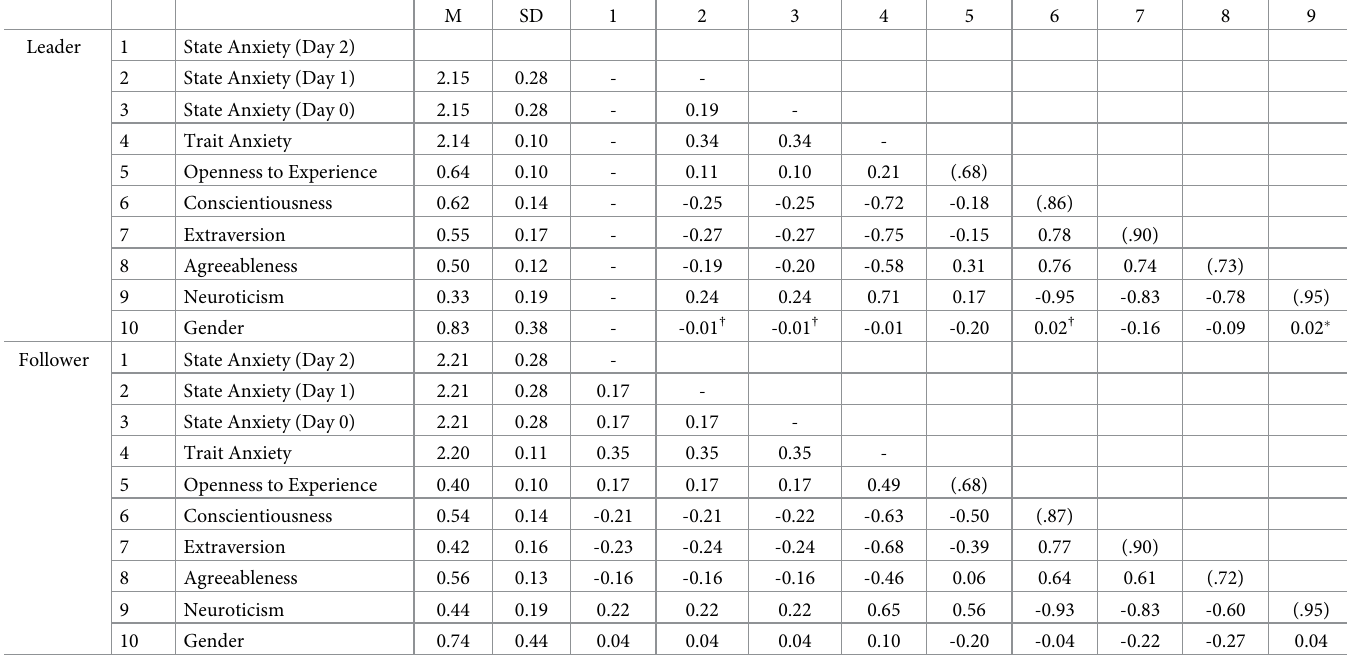
Table 1. Pairwise correlations of main